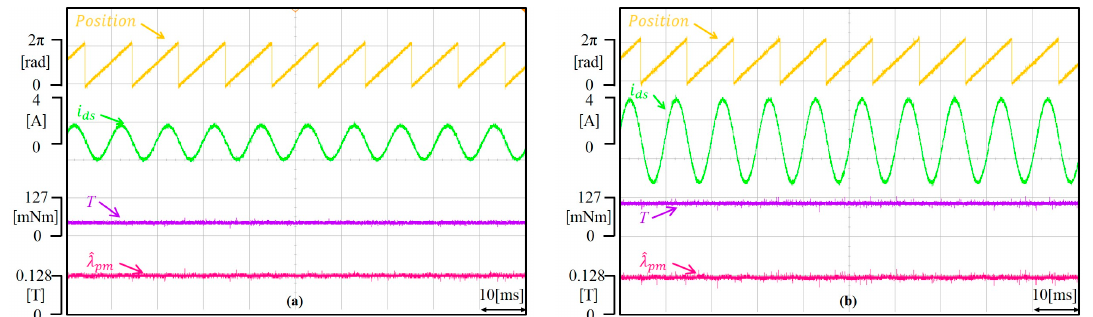
Figure 13. Steady state responses of the test SPMSM drive without applying the proposed algorithm. ( a ) Torque command: 50 mNm ( b ) Torque command: 127 mNm. (Operating condition: ω r = 620 rad/s, permanent magnet temperature = 25 °C).